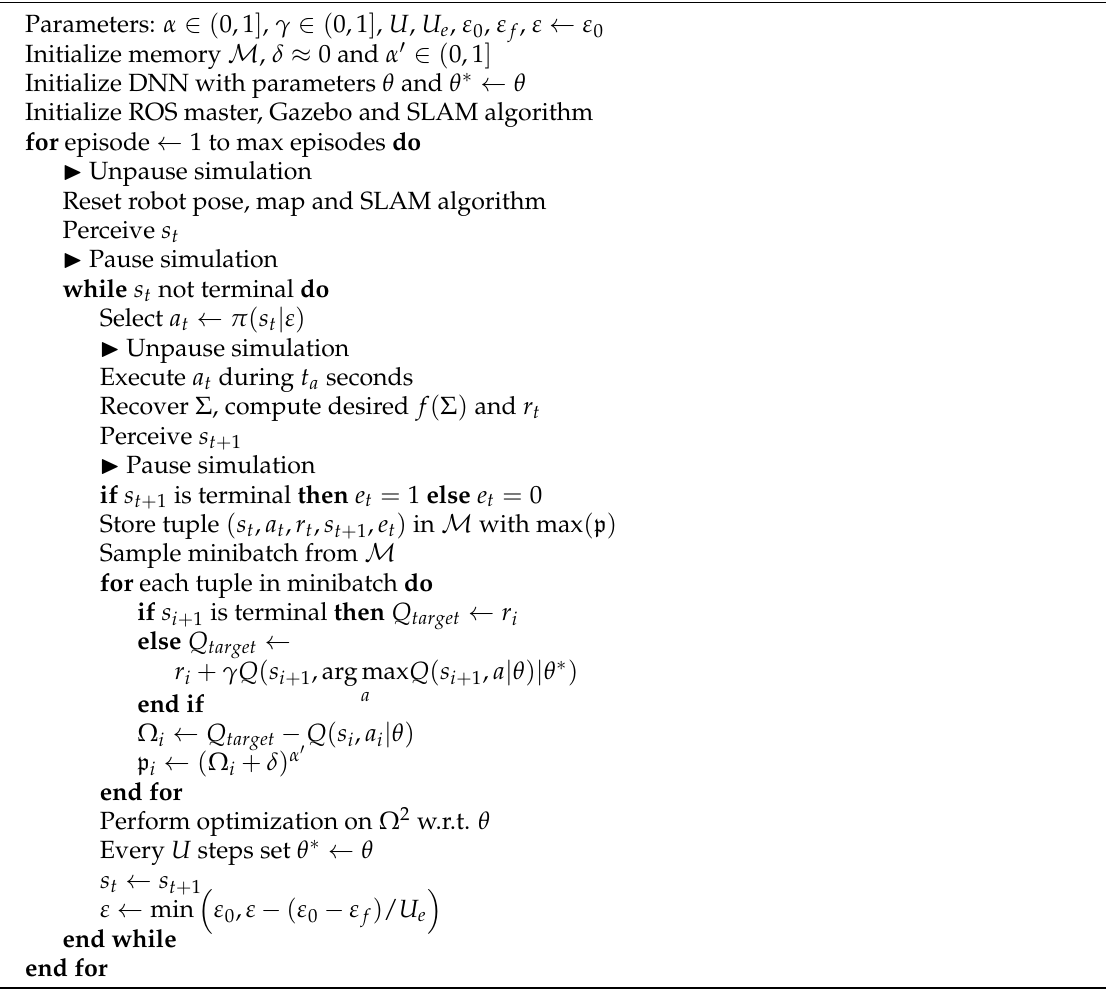
Algorithm 2 Dueling Double Deep Q-learning with PER in simulation